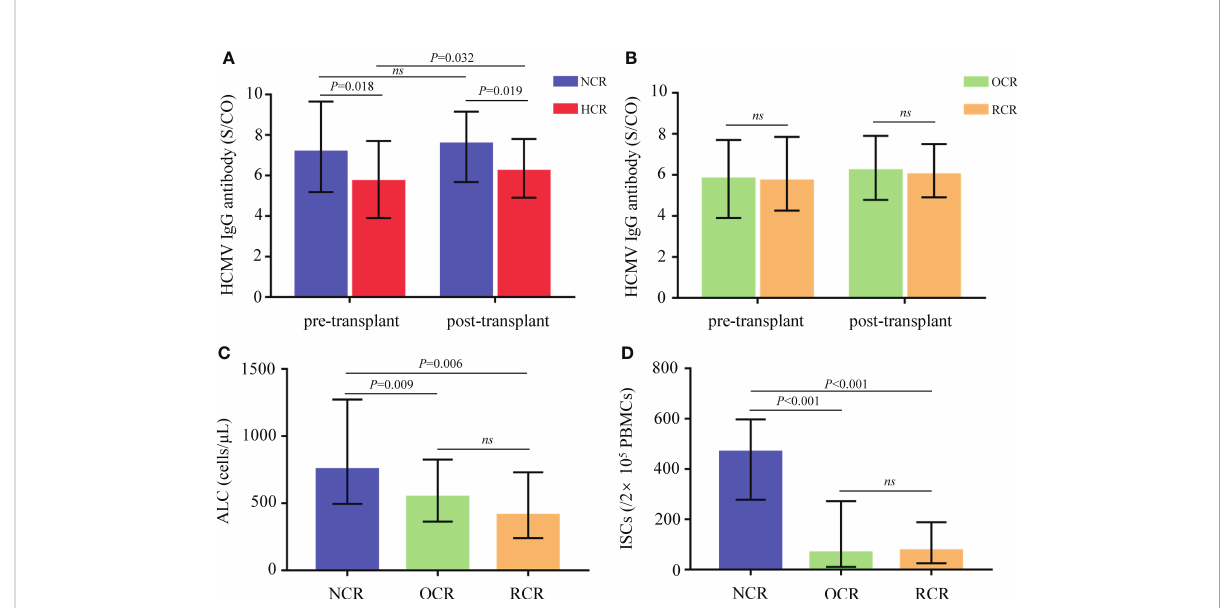
FIGURE 2 Biomarkers between different groups of recipients. (A) Comparisons of pre- and post-transplant HCMV IgG antibody concentrations in recipients from the NCR and HCR groups. (B) Comparisons of pre- and post-transplant HCMV IgG antibody concentrations in recipients from the OCR and RCR groups. (C, D) Comparisons of ALC and ISCs in recipients from the NCR, OCR and RCR groups. Medians with IQR are shown for each group. ALC, absolute lymphocyte count; ISCs, HCMV speci fi c IFN- g secreting cells; NCR, recipients without HCMV reactivation; HCR, recipients with HCMV reactivation; OCR, recipients with one episode of HCMV reactivation; RCR, recipients with recurrent HCMV reactivation; ns, no signi fi